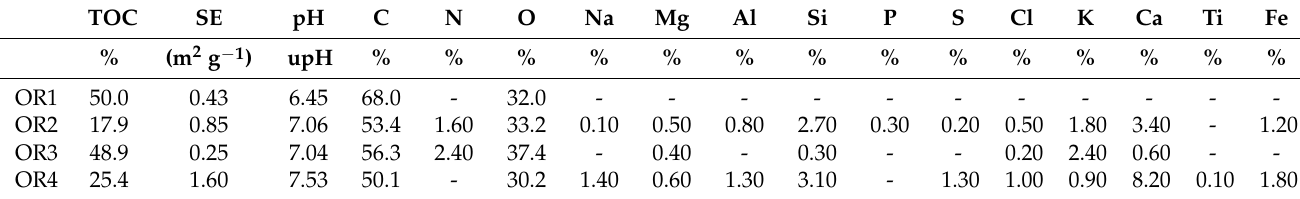
Table 1. Physicochemical properties of the studied